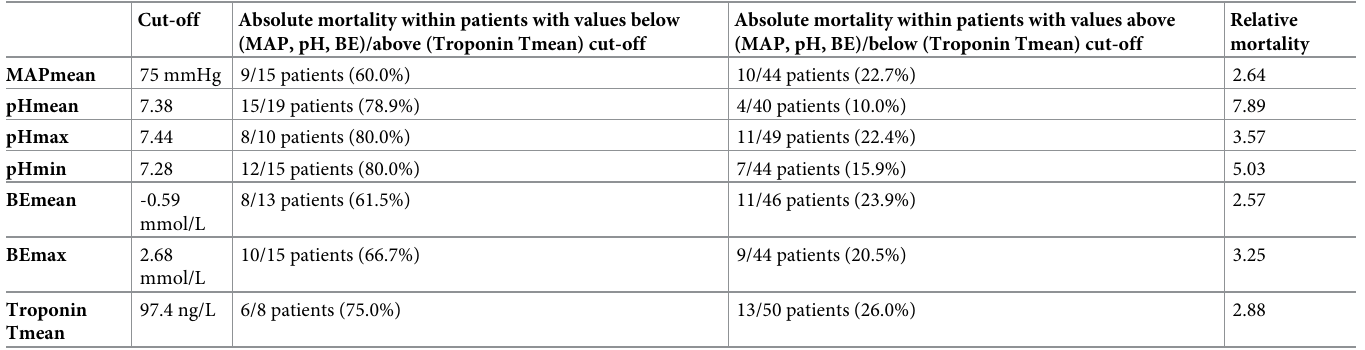
Table 1. Relative mortalities. Cut-off